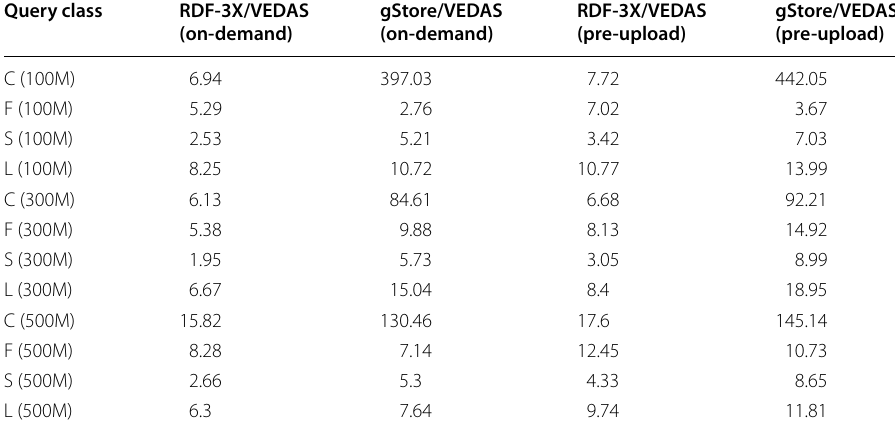
Table 6 Speedup compared to RDF-3X and gStore Query class